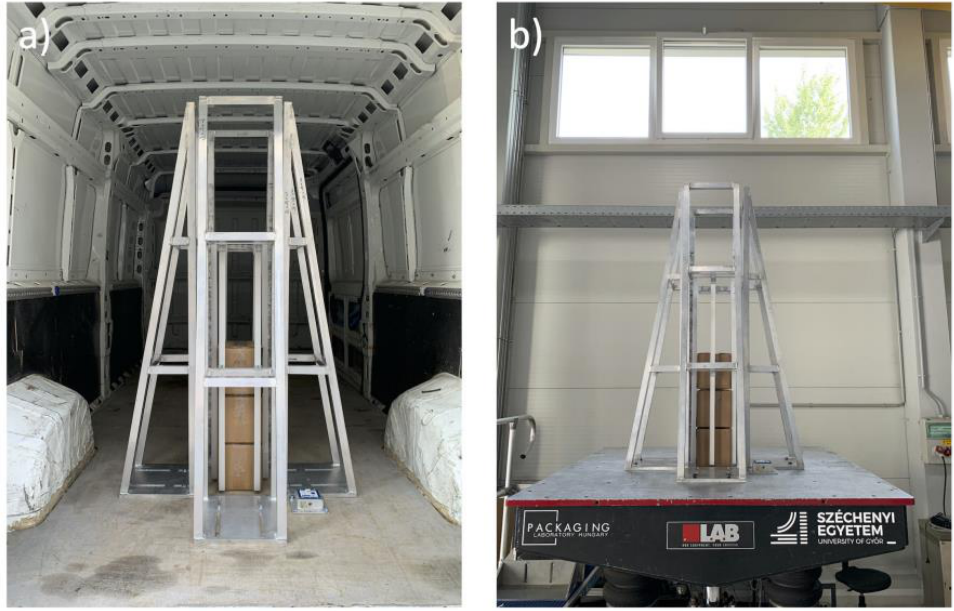
Figure 3. ( a ) Sample stacked unit in van and ( b ) in laboratory.